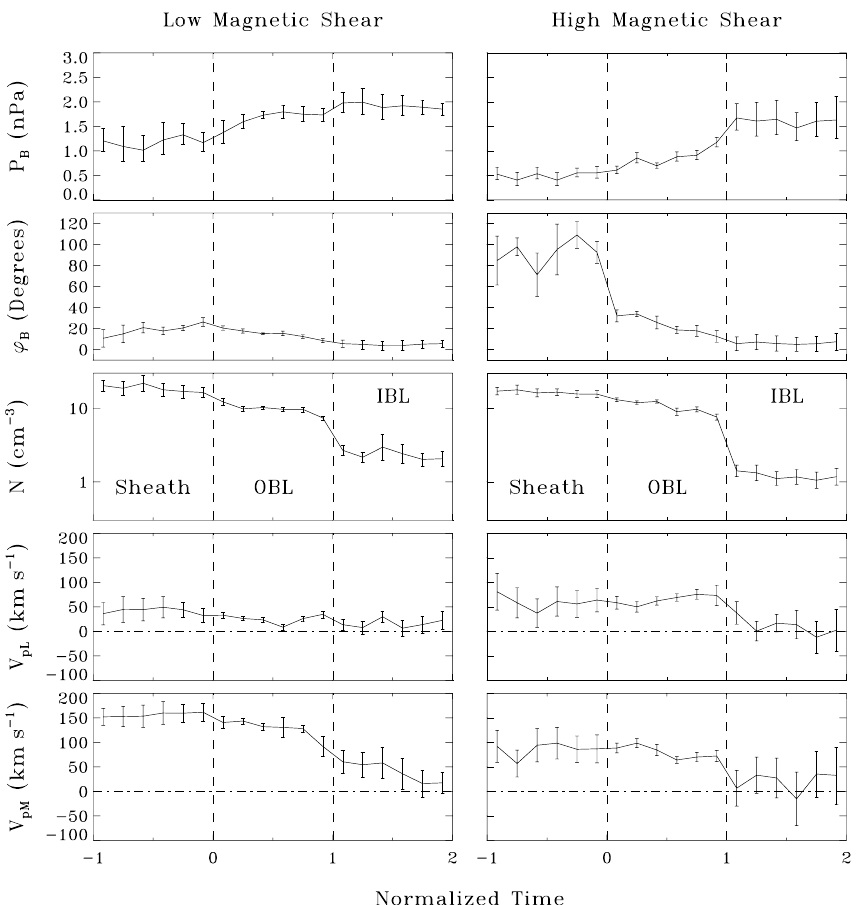
Fig. 2. Superposed epoch analysis of the magnetic pressure, P B , the mag- netic field rotation angle, ϕ B , the total plasma density, N , and the components V pL , V pM of the proton bulk velocity across the outer boundary layer. The sign of V pL is reversed for crossings at southern latitudes and the sign of V pM is reversed for crossings duskward of local noon. The left panels display data from 7 low shear crossings and the right panels display data from 15 high shear crossings. Normalized time ˆ t = 0 cor- responds to the magnetopause and nor- malized time ˆ t = 1 corresponds to the interface between the OBL and the IBL. Vertical error bars indicate the standard deviation of the average of each param-